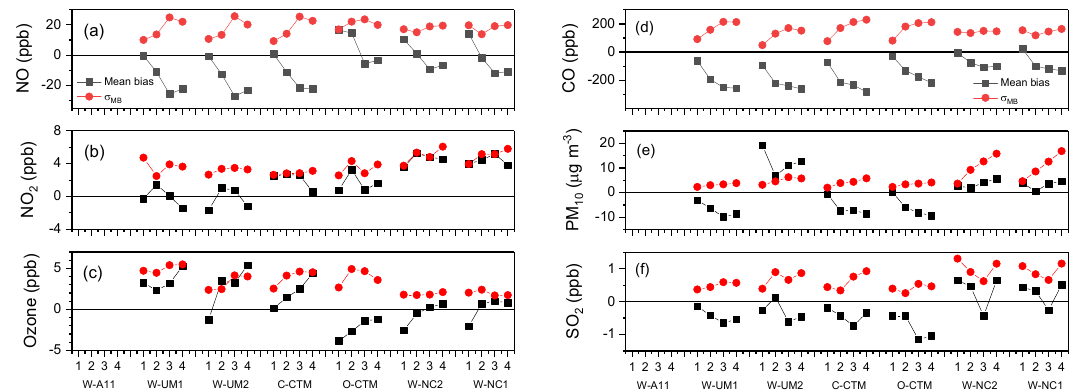
Figure 18. Mean bias (µ MB ) and σ MB for ( a ) NO, ( b ) NO 2 , ( c ) O 3 , ( d ) CO, ( e ) PM 10 , and ( f ) SO 2 , at Westmead for all models and atmospheric mixing states.